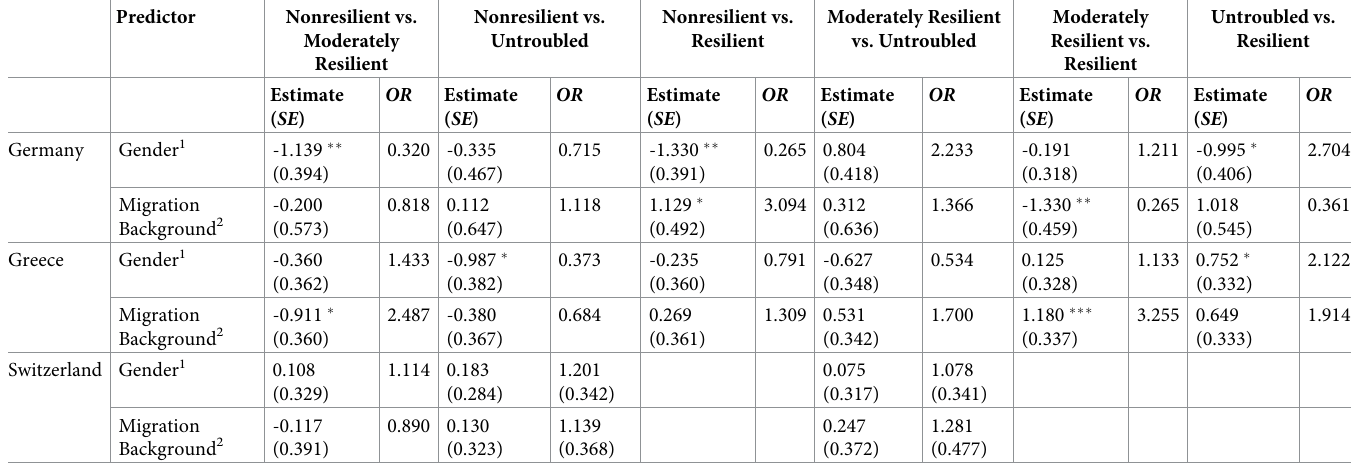
Table 5. Multinomial logistic regression model results for gender and migration background for Germany, Greece, and Switzerland (R3STEP).